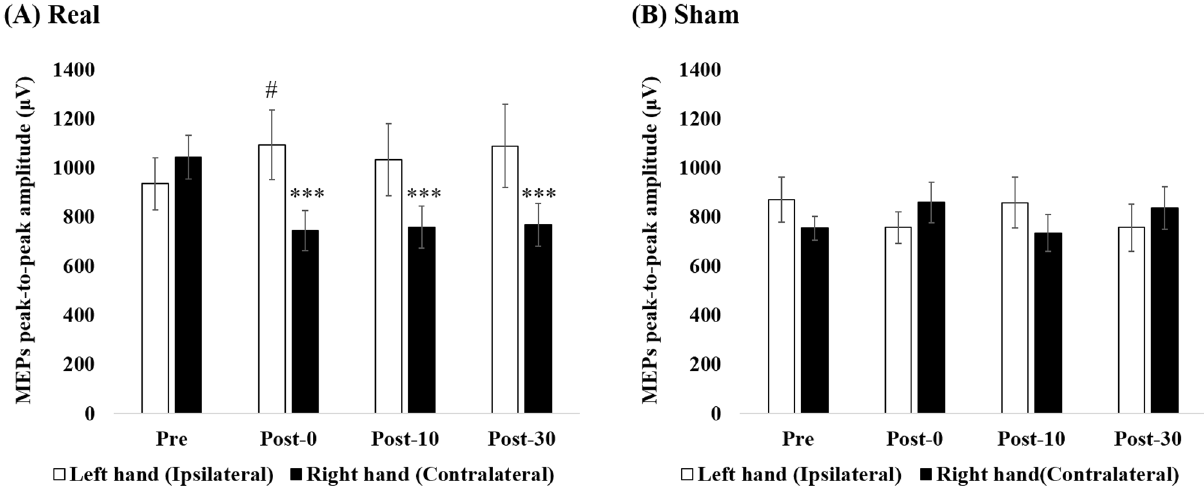
Figure 3. Effects of tSMS on the MEPs peak-to-peak amplitude in the right and left FDI muscle. Time × Hands × Group interaction was significant. When analyzed separately for real ( A ) and sham ( B ) tSMS conditions by two-way repeated-measures ANOVA, Time × Hands interactions was detected only for the real condition. On the other hands, there was no significant Time × Hands interactions in the sham condition. In the real condition, post hoc analysis showed that MEPs peak-to-peak amplitude was significantly decreased at Post-0, 10, and 30 compared to at Pre in the right hand (***p < 0.005 vs Pre). In the left hand, it was significantly increased at Post-0 compared to at Pre ( # p < 0.05 vs Pre). Error bar are standard errors of the mean.